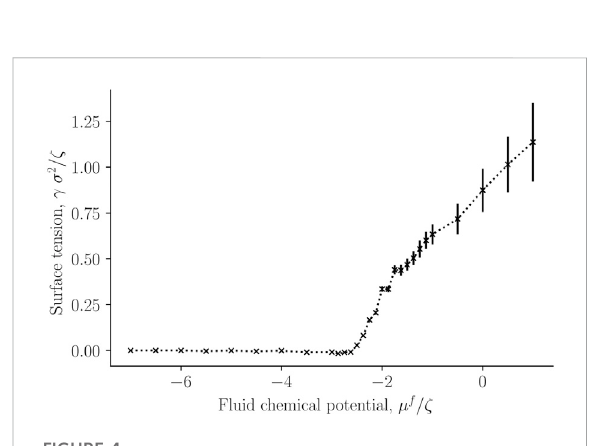
FIGURE 6 Fluid number density ρ f = N f / V as a function of fl uid chemical potential μ f at varying porosity ϕ = V f / V